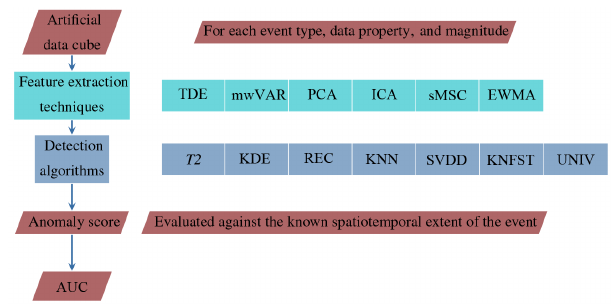
Figure 3. Data processing for detecting multivariate anomalies. We extract relevant features from each artificial data cube before apply- ing the detection algorithms. The detection algorithms output some anomaly score, which we evaluate against the known extent of the event using the area under the curve (AUC). Feature extraction ele- ments on the right-hand side are understood as options and can be combined with each